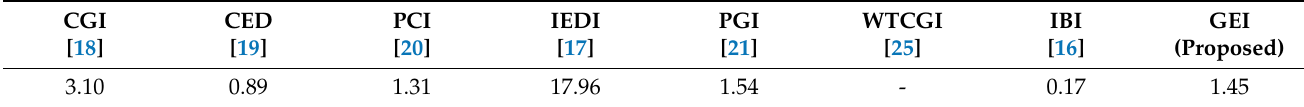
Table 5. Average runtime (in seconds) for interpolating 12 test images.